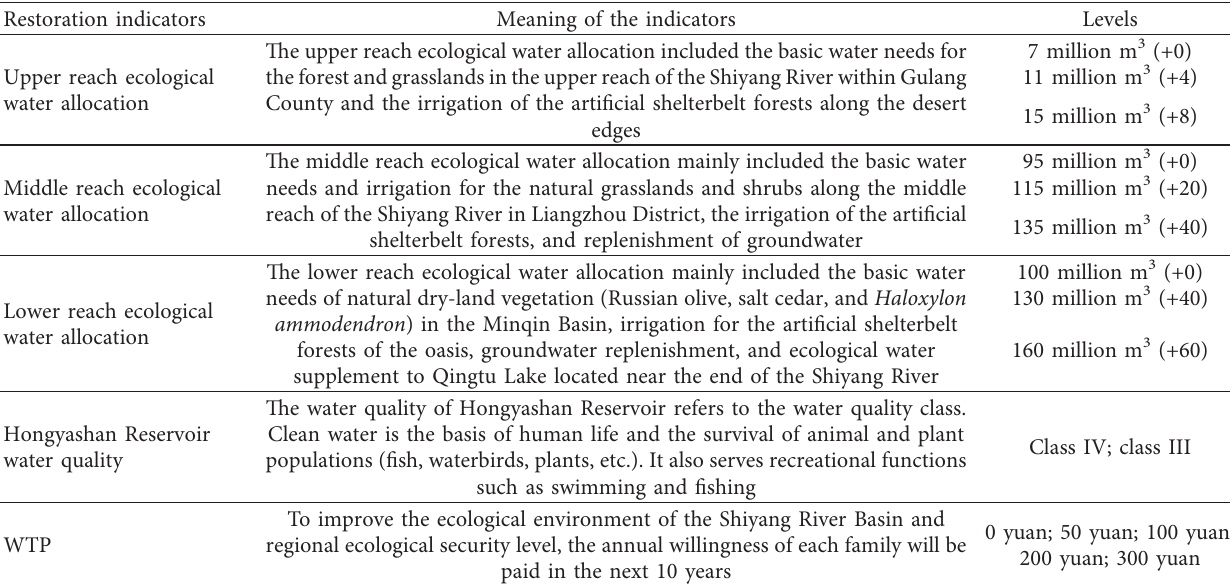
Table 1: Ecological restoration indicators for the Shiyang River